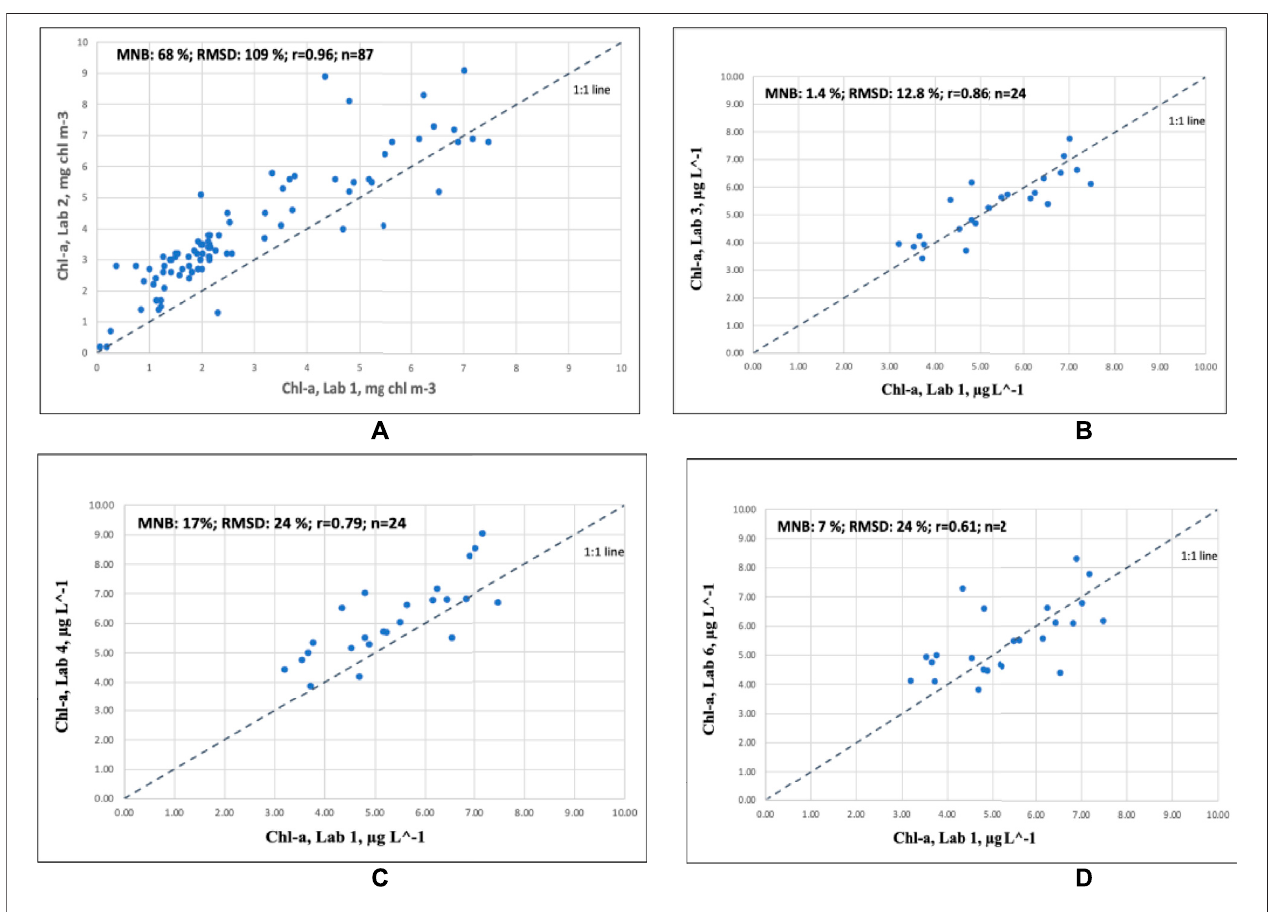
FIGURE6| UncertaintiesofChl-ameasurementsof (A) Lab2vs.Lab1(1998,2020,and2021normalsamplingprocedures), (B) Lab3vs.Lab1(2010and2021), (C) Lab 4 vs. Lab 1 (Bråviken), and (D) Lab 6 vs. Lab 1 (Bråviken).